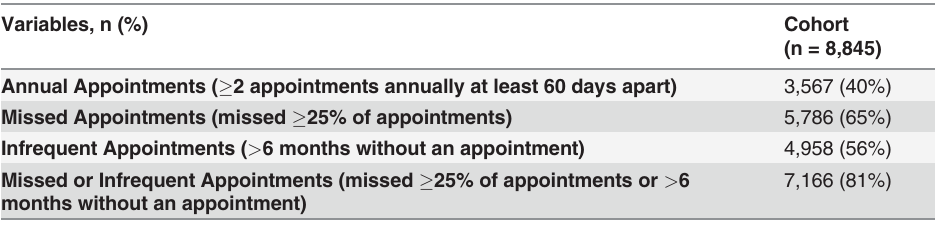
Table 2. Retention measures at 24